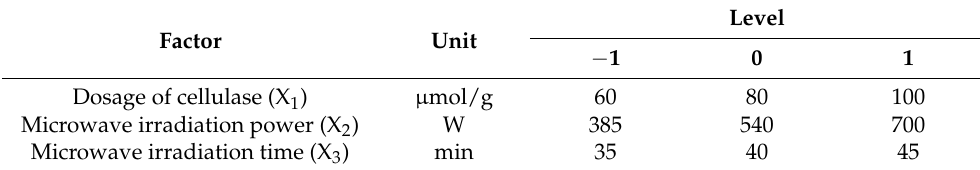
Table 1. Factor and Levels in Response Surface